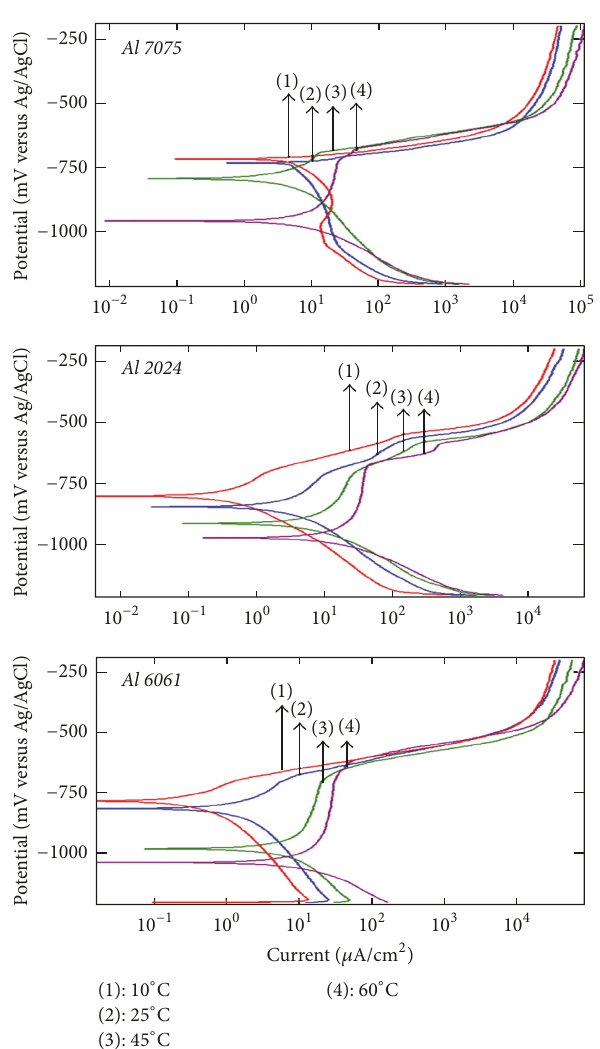
Figure 10: Potentiodynamic polarization curves of Al alloys in the Red Sea water at different